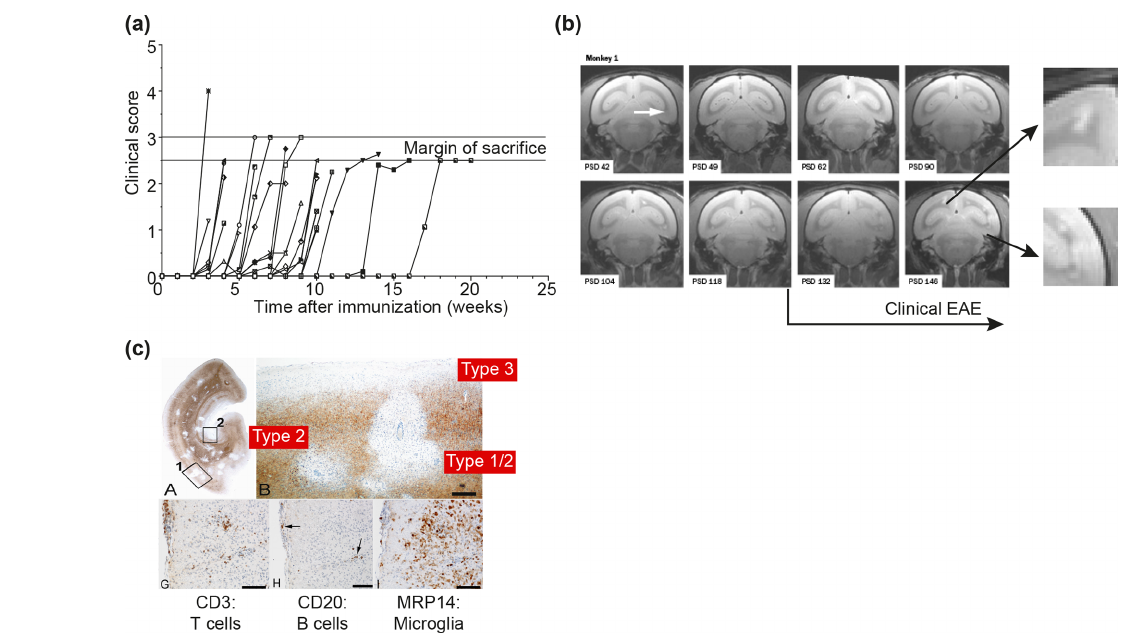
Figure 7. Clinical and pathological aspects of the marmoset EAE model induced with rhMOG/CFA . (a) Depicted is the EAE course in a representative selection of 30 unrelated marmosets receiving a single immunization with rhMOG/CFA on day 0. All monkeys developed clinically evident EAE, but the time of onset varied from 2 to 16 weeks. (b) Serial imaging of a case with late EAE onset, showing early onset of brain lesion formation. The white arrow points to the first detectable lesion. Clearly visible is that formation of new lesions in the depicted brain slice (0.5mm) is disseminated in time and space. Around the time that clinical signs were diagnosed, lesion colonization of cortical grey matter is detectable (inserted magnifications). (c) PLP staining of a brain hemisphere shows the dramatic demyelination in white and grey matter (a) . Different grey matter lesion types identified in the MS brain can be distinguished (b) . Lesions are paucicellular with regard to T (CD3) and B (CD20) cells, but contain abundant MRP14 + myeloid cells, representing microglia and